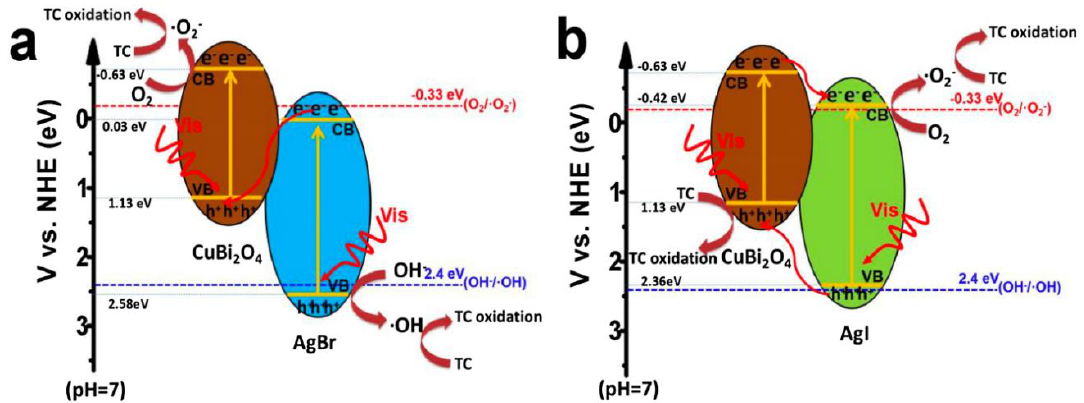
Figure 7. ( a ) Z-scheme mechanism of AgBr/CuBi 2 O 4 composite and ( b ) type II heterojunction mechanism of AgI/CuBi 2 O 4 composite